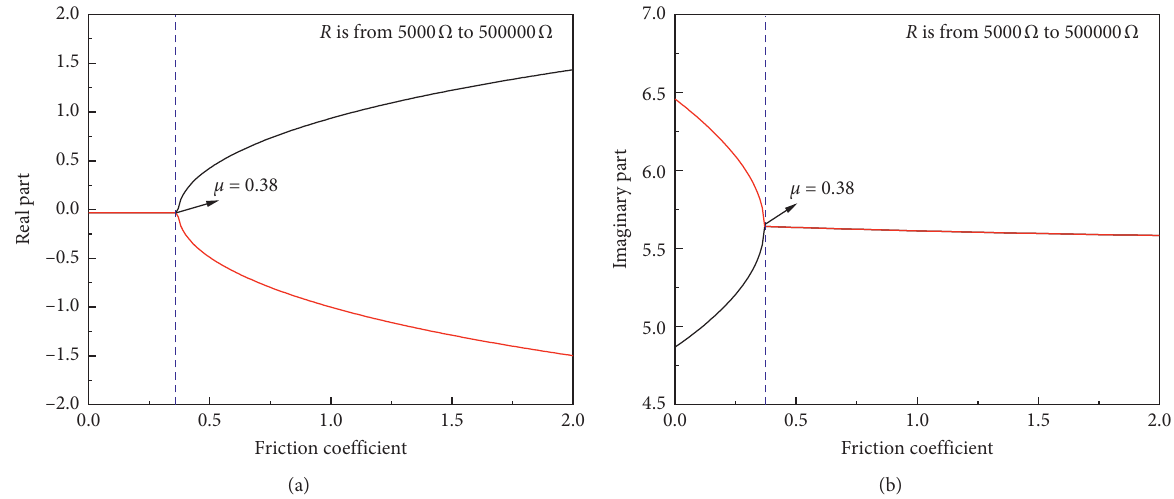
Figure 19: The real parts (a) and imaginary parts (b) of the friction system with the variation of external electric